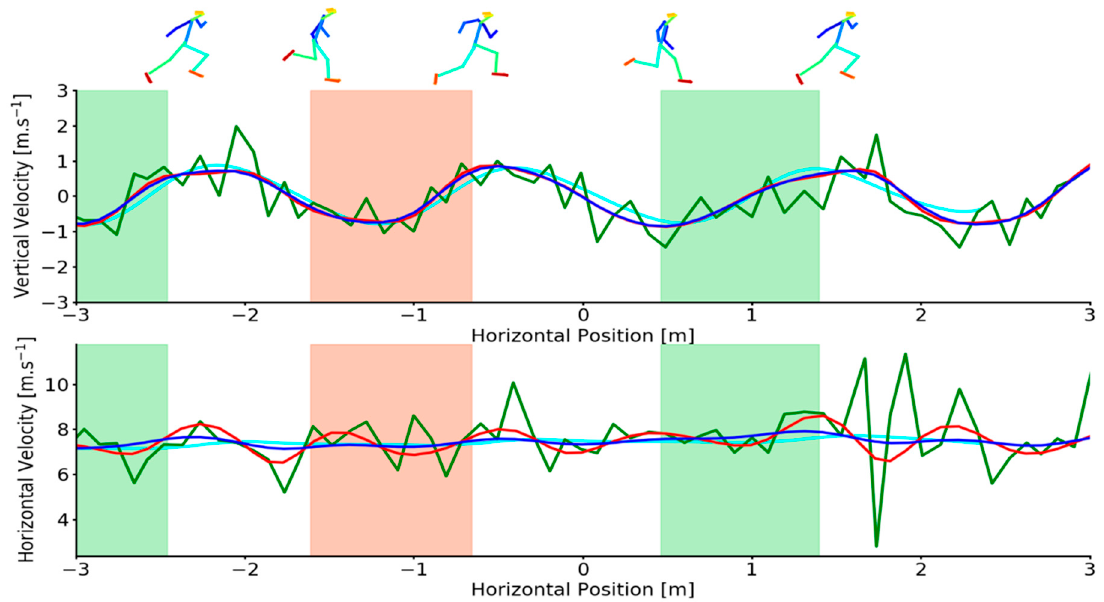
Figure 2. Upper-Example individual trial demonstrating vertical CoM velocities for criterion (cyan), unfiltered (green), low-pass filtered (red) and Kalman smoothed (blue) data as a function of horizontal CoM position during sprinting. Lower -Example individual trial demonstrating horizontal CoM velocities for criterion (cyan), unfiltered (green), low-pass filtered (red) and Kalman smoothed (blue) data as a function of horizontal CoM position during sprinting. Shaded areas depict the left foot (red shading) and right foot (green shading) stance phase. Footfall events were computed from marker-based foot kinematics [32] . OpenPose joint centre reconstructions (top) at touch-down and toe-off events are overlaid for context.